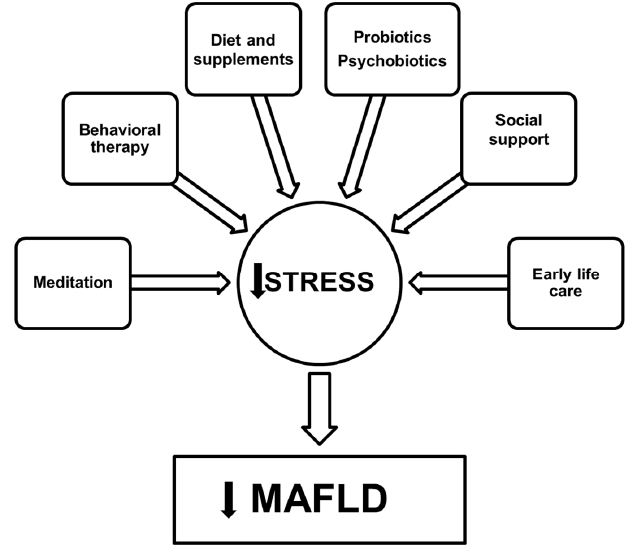
Figure 2. Major suggested interventions for stress management with potential beneficial effects on MAFLD. Meditation interventions have proven effective on cortisol levels, stress-related symptomatology, eating behaviors, and inflammation. Behavioral therapy can help the patients with motivation and adherence to lifestyle modifications, including diet, and appropriate psychotherapy is mandatory for patients at high risk of psychiatric comorbidities such as MDD. Diet remains the main pillar in MAFLD therapy, with particular emphasis on its anti-inflammatory and microbiota-regulating properties, which can be enhanced with appropriate supplements, probiotics, and psychobiotics,